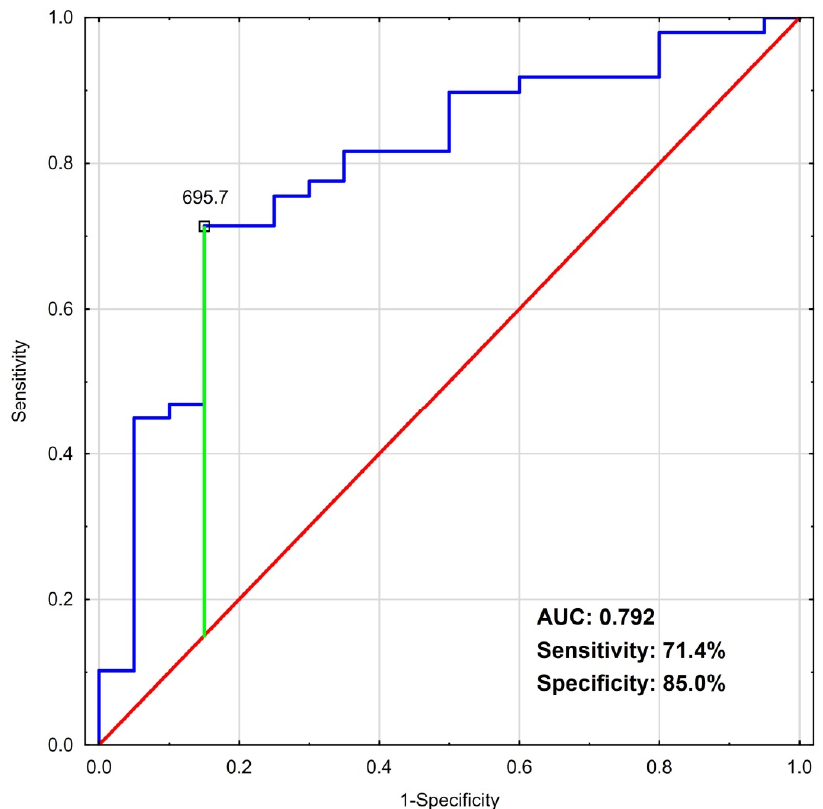
Figure 2. ROC analysis of S100B as a predictor of poor clinical outcome (CPC 3–5 or death). Ab- breviations: AUC—area under the curve; CPC—cerebral performance category; ROC—receiver operating characteristic.